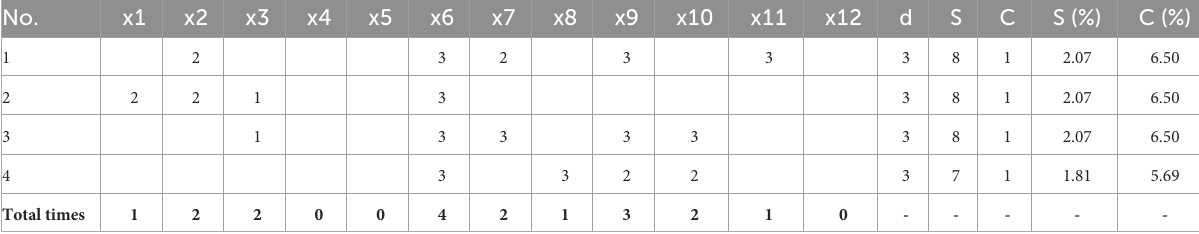
TABLE 8 Decision rules of high intention to use GMFs with minimum support value ≥ 7. No.